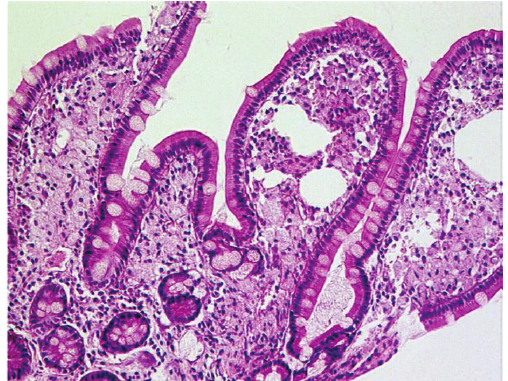
Figure 13: Whipple’s disease: obvious enlargement of the villi filled by foamy macrophages. Hematoxylin-eosin staining. Courtesy of Jan Noˇziˇcka, MD, PhD. Reproduced with permission from Bureˇs and Rejchrt